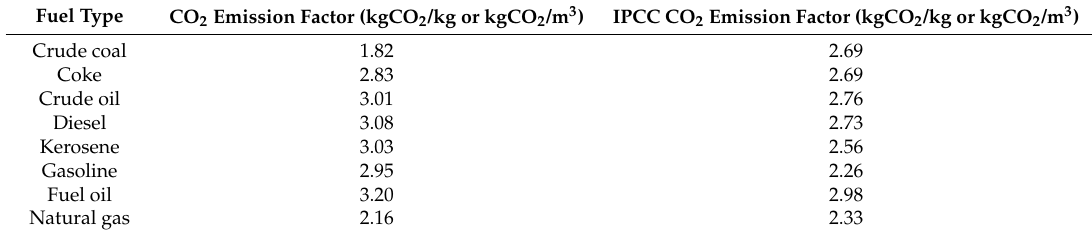
Table 5. CO 2 emission factor from IPCC and this